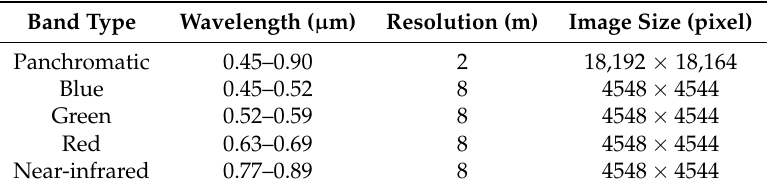
Table 1. Detailed information of GaoFen-1 satellite images.